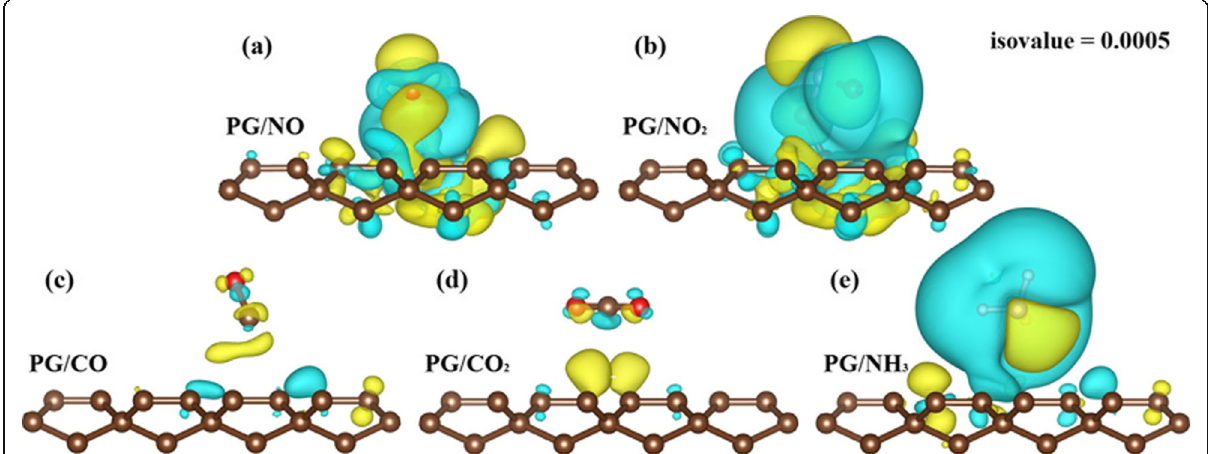
Fig. 2 Charge density difference plots. The adsorption configurations and charge transfer for each case in a different order from Fig. 1 are plotted in a – e . The yellow isosurface indicates an electron gain, while the blue one represents an electron loss. The unit of isosurface value is e Å − 3 . Apparently, electron transfer in covalent a PG/NO and b PG/NO 2 structure are much more obvious than others